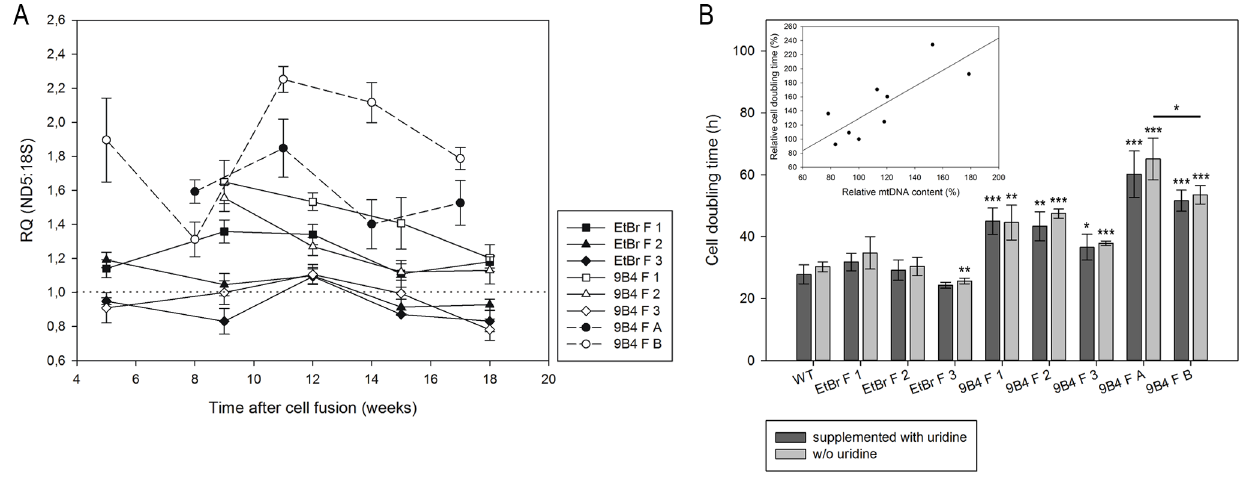
Figure 4. Relative quantification of mtDNA and cell growth analysis of PC-3 fusion cells. A Analysis of mtDNA relative to nuclear DNA over a period of 18 weeks after cell fusion of PC-3 r 0 cells and cytoplasts of PC-3 MTS-DsRed (F 1–3, solid lines) or PC-3 MTS-EGFP r 0 cells and cytoplasts of PC-3 MTS-DsRed (F A) and cytoplasts of 143B.TK - MTS-DsRed (F B) (dashed lines) using a primer set for amplification of nuclear (18S rDNA) and mitochondrial (ND5 gene) DNA. Data were normalized to measurements of untreated wild type cells (dotted line). Data represent means 6 SD obtained in three determinations. B Calculation of doubling time of PC-3 cells in media with uridine (dark grey bars) and without uridine (light grey bars). Total cell number was measured every 24 h over a period of six days and cell doubling was estimated using exponential regression. The presented data are means 6 SD obtained in four experiments. Significance levels between wild type and the different fusion cell lines or if designated between two fusion cell lines were indicated. *P , 0.05, **P , 0.01, ***P , 0.001. B Inset Comparison of relative mtDNA content and cell doubling time. MtDNA content and cell doubling time of PC-3 fusion cells cultured without uridine (close symbols) were normalized to wild type cells and a linear regression was performed (solid